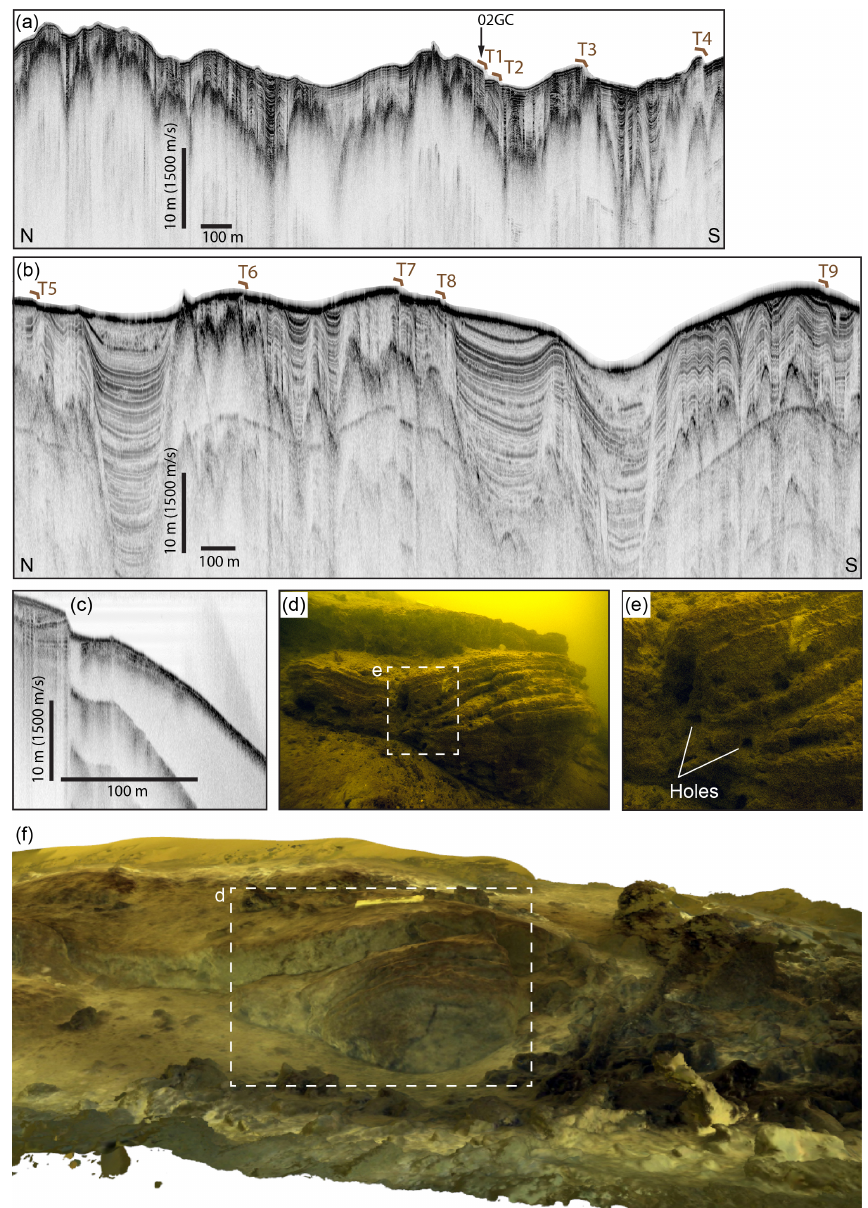
Figure 5. Sub-bottom profiles and bottom photographs portraying sea floor terraces. (a, b) Sub-bottom profiles SBP1 (a) and SBP2 (b) from the area east of Askö. The locations of terraces clearly identified in the multibeam bathymetry are marked T1–T9 (see Fig. 2a). The site of core Asko2018HT-2GC (02GC on profile SBP1) is shown with a black arrow. Note that it is located on top of terrace T1. (c) Sub-bottom profile across the terrace mapped west of the island of Kastellholmen in Stockholm Harbour. Bottom photographs are shown in (d, e) and a 3-D photomosaic of this terrace in (f)